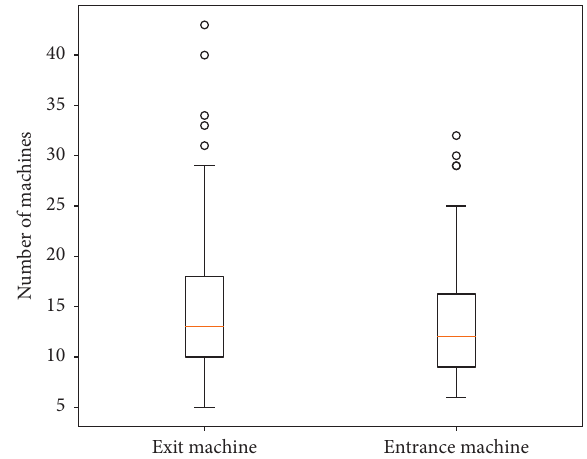
Figure 6: Number of entrance and exit fare machines in the studied metro